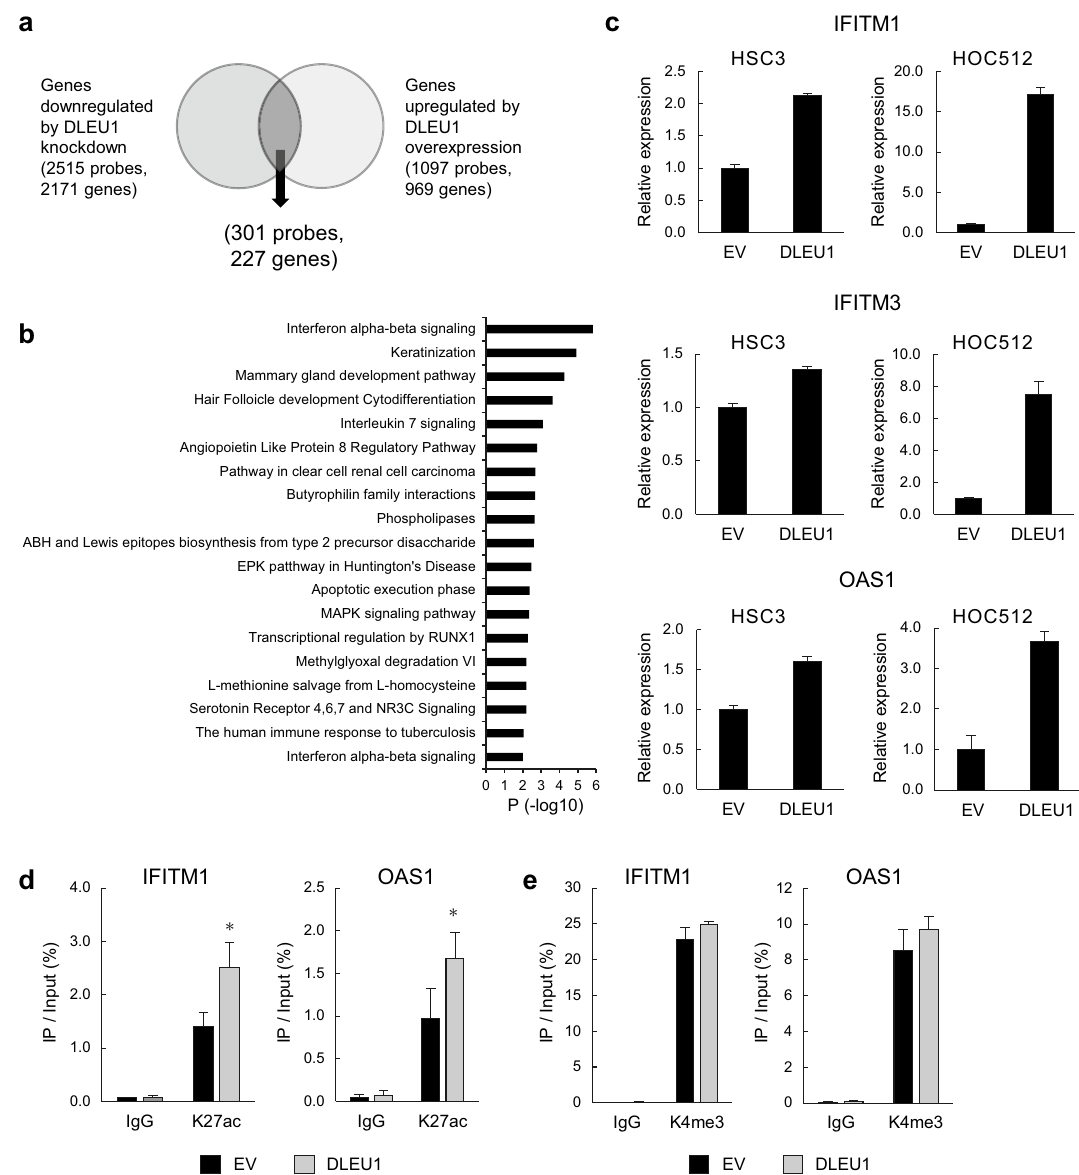
Figure 3. Effects of DLEU1 overexpression on expression and histone modification at ISGs in OSCC cells. ( a ) Venn diagram showing genes downregulated by DLEU1 knockdown and/or upregulated by DLEU1 overexpression detected by microarray analysis of Ca9-22 cells. ( b ) Pathway analysis of selected genes from ( a ). ( c ) qRT-PCR analysis of representative ISGs in the indicated OSCC cells infected with an empty lentivirus vector (EV) or DLEU1 expression vector. ( d , e ) ChIP-qPCR analysis showing levels of H3K27ac ( d ) and H3K4me3 ( e ) at TSS regions of the indicated genes in HSC3 cells infected with the indicated lentivirus vectors. * P <